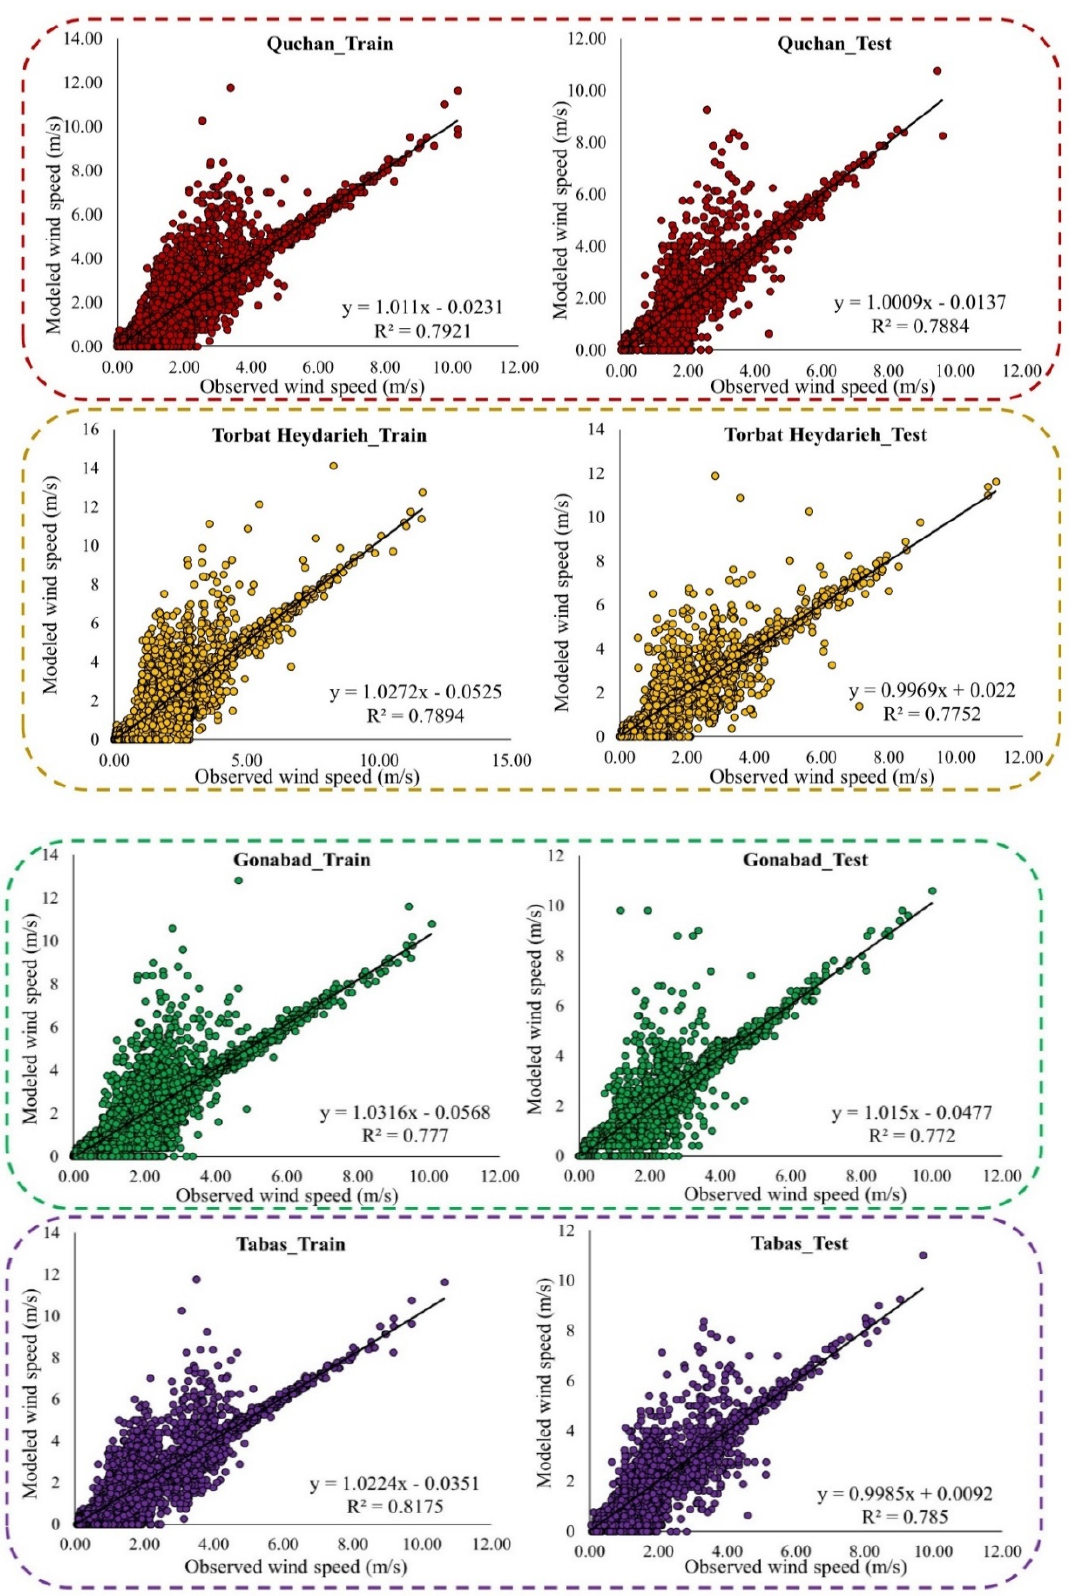
Figure 7. Scatter plots of the observed and modeled values of WS using the meta-algorithm at different stations.